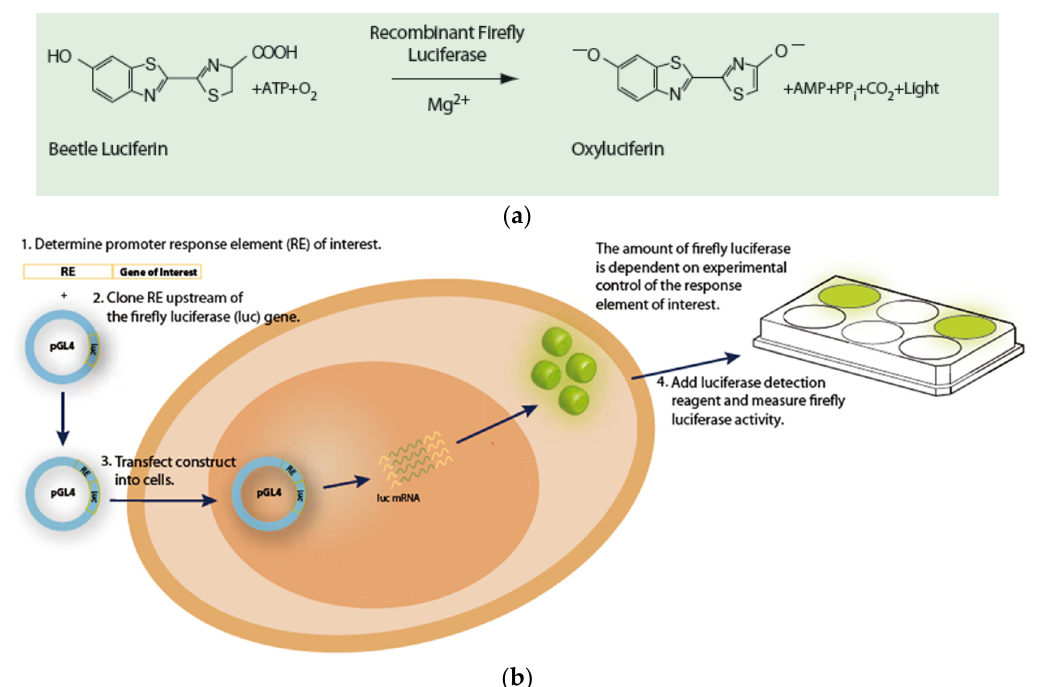
Figure 4. The reaction catalyzed by Firefly ( Photinus pyralis) luciferase ( a ) and treatment of transfected cells and measurement of biological stimulation by determining the amount of active luciferase ( b ). Reprinted with permission from Ref. [90]. Copyright 2008, Promega Corporation.